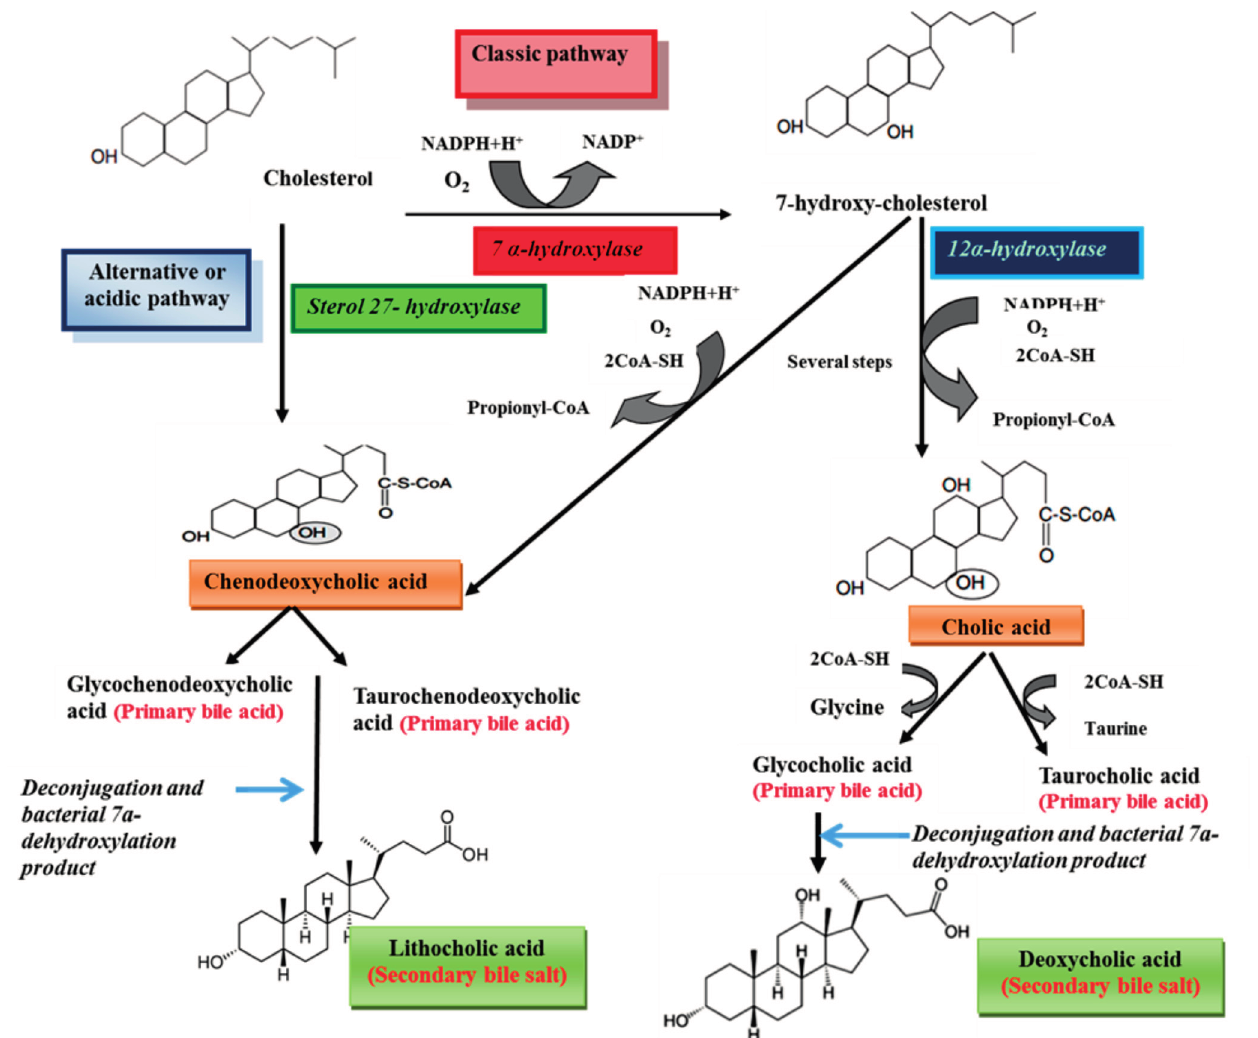
Scheme1. Schematic representation of bile acids biosynthesis from